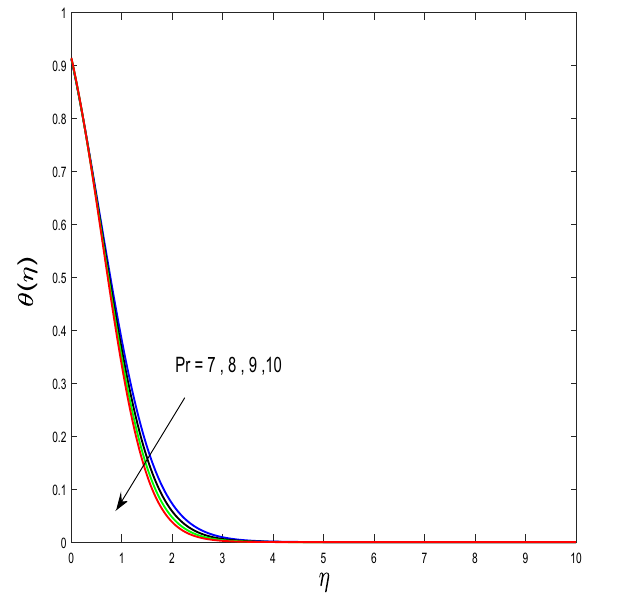
Figure 9. Plot of θ for Pr .